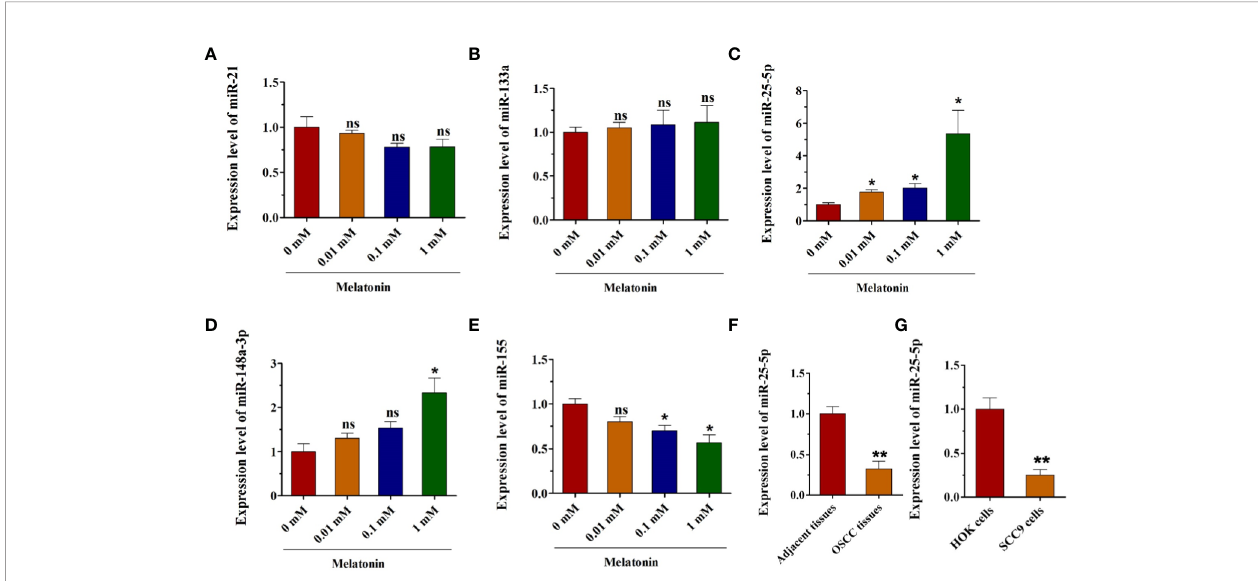
FIGURE 2 | Melatonin increases the expression of miR-25-5p in OSCC cells. (A – E) RT-qPCR analysis of miR-21, miR-133a, miR-25-5p, miR-148a-3p, miR-155 expression was performed in SCC9 cells after treating with melatonin at 0.01, 0.1, and 1 mM for 48 h (n=4, One way ANOVA followed by the Tukey ’ s test, * indicated the differences compared with 0 mM Melatonin group). (F) Relative miR-25-5p levels in OSCC tissues (n=35, Student ’ s t-test). (G) RT-qPCR analysis was utilized to examine the expression of miR-25-5p in SCC9 and HOK cells (n=4, Student ’ s t-test) (*p < 0.05, **p < 0.01, ns, no statistical